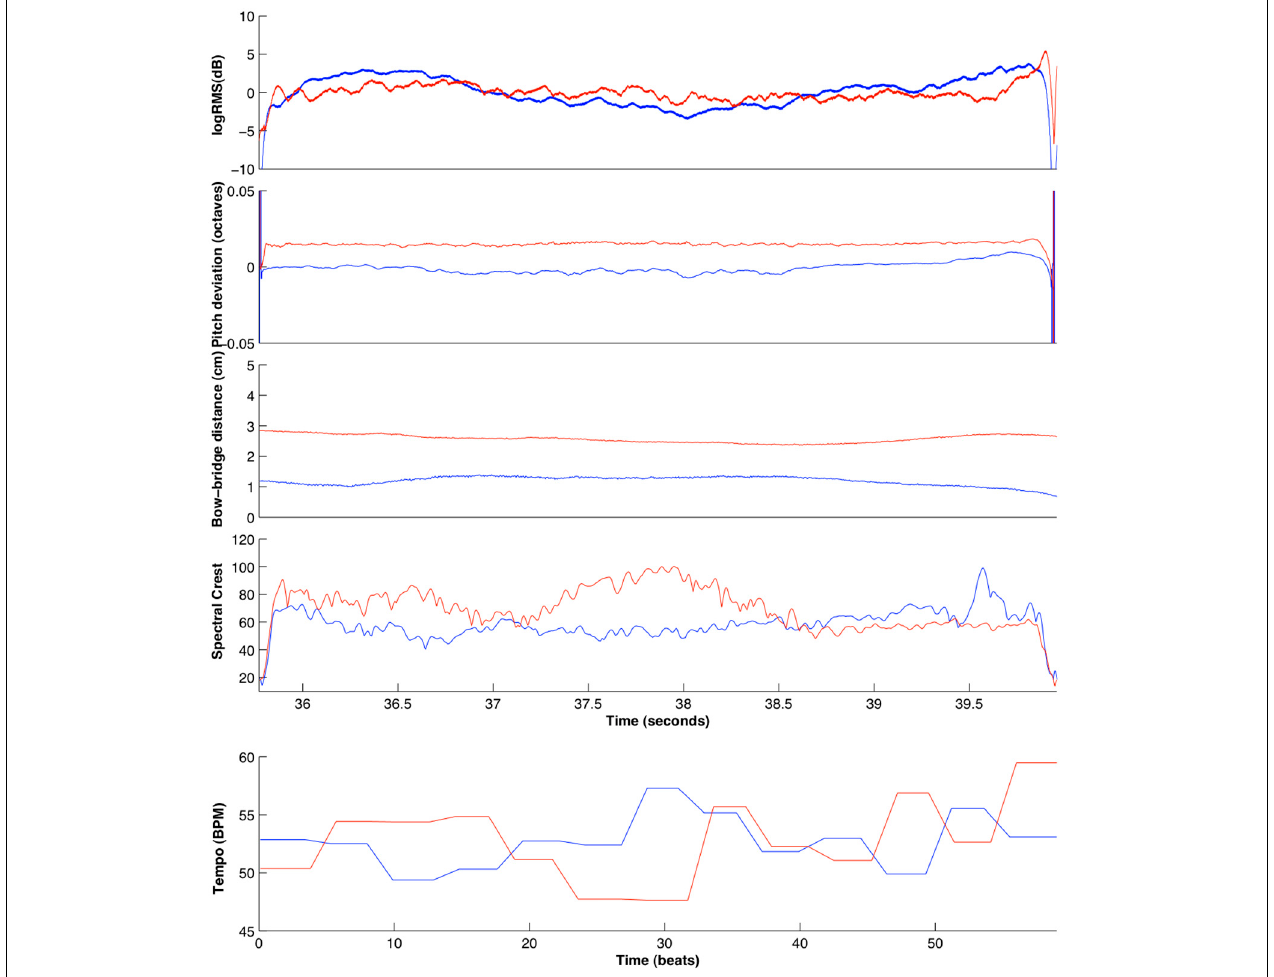
FIGURE 7 | Comparison of all extracted features for the ensemble (blue) and solo (red) recordings of violin 1, for an excerpt of exercise D1 (for the pitch deviation, logRMS, bow-bridge distance, and spectral crest features) and the entire exercise (for the tempo curve feature).